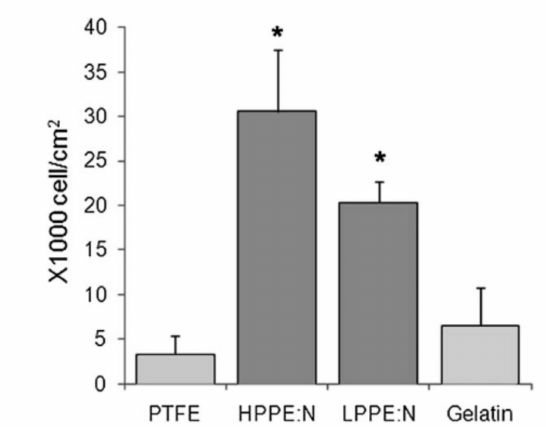
Figure 3. Human umbilical vein endothelial cell adhesion after 4 h on PTFE films, bare and coated with gelatin or with plasma polymerized coatings using low- (LPPE:N) and atmospheric-pressure (HPPE:N) plasma discharges. * p < 0.05 compared to uncoated surfaces. Copyright (2011) Wiley. Used with permission from